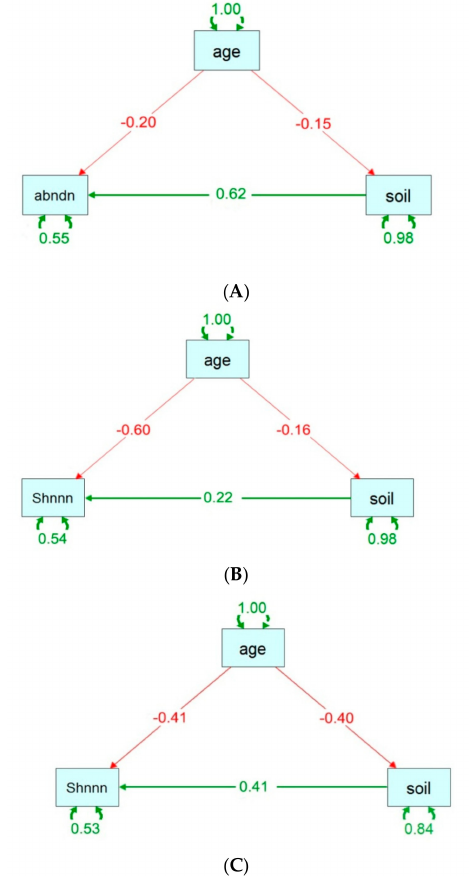
Figure3. Structuralequationmodeling(SEM)for( A )shrubabundance, ( B )herbShannon, and ( C ) shrub Shannon, linking the soil variables with species abundance and diversity. The stand age was fitted as direct pathways of influence on the abundance or diversity, while the stand age via the soil condition was fitted as indirect pathways of influence. The abbreviations are denoted as follows: abndn (abundance), shnnn (Shannon’s diversity index), age (stand age), and soil (composite soil